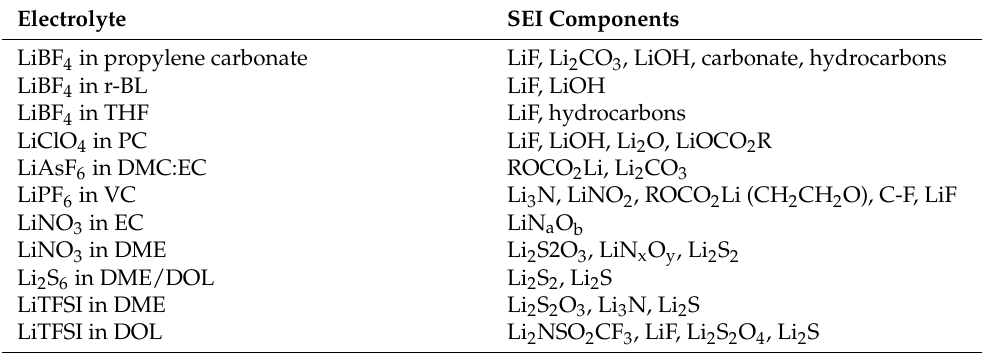
Table 7. Possible SEI components in Li-based electrolytes.